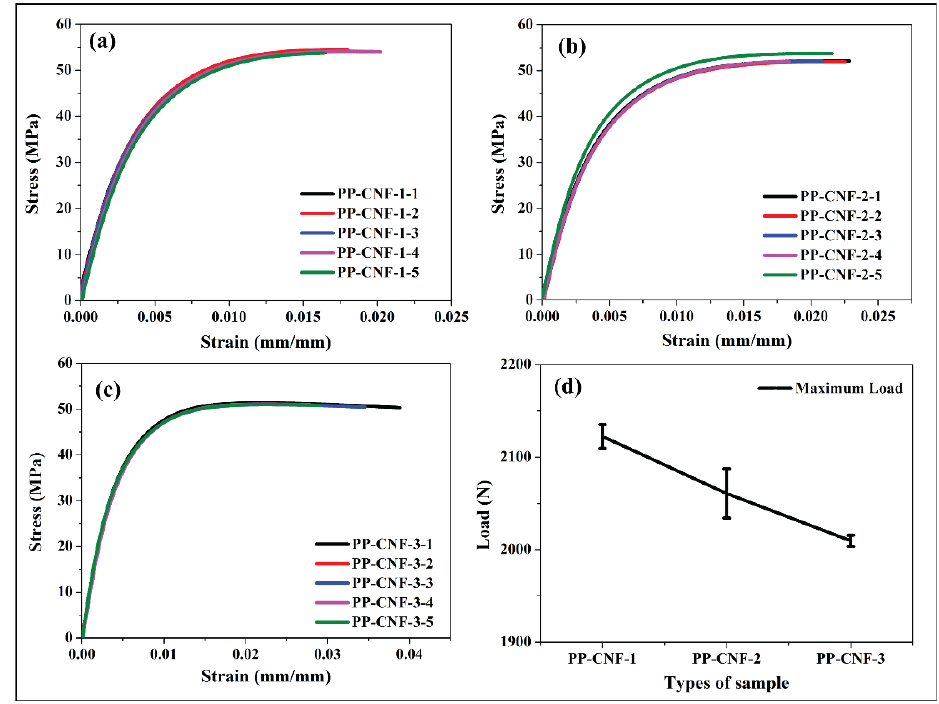
Figure 5. Stress-strain curve of ( a ) PP-CNF-1, ( b ) PP-CNF-2, ( c ) PP-CNF-3, and ( d ) Maximum tensile load variation with different PP nanocomposites.